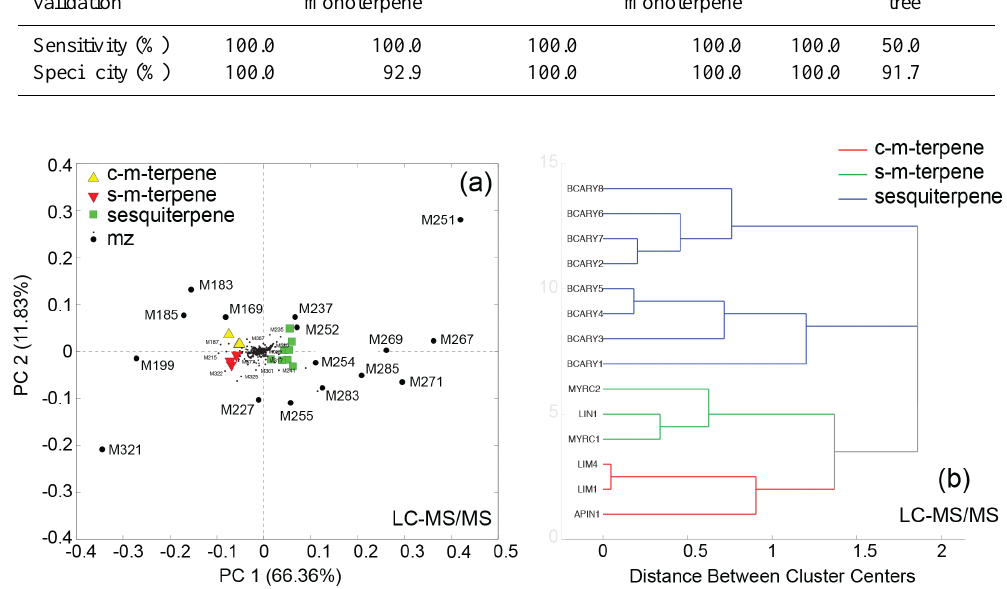
Table 4. PLS-DA model classification sensitivity and specificity for the gas-phase biogenic air matrices. Cross- Isoprene Cyclic- Fig tree validation monoterpene